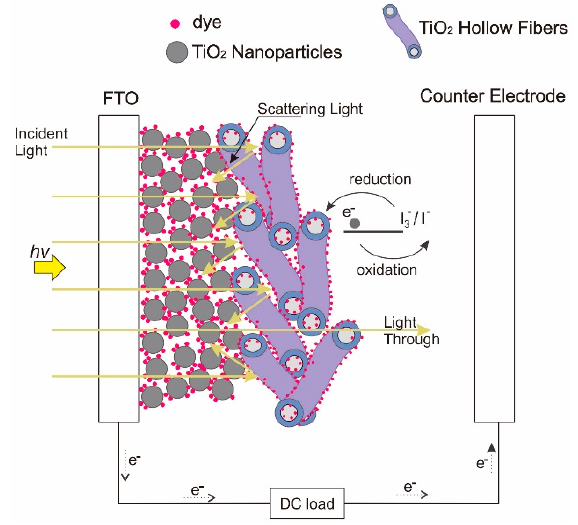
Figure 8. Structure of DSSCs with double-layer photoanode.